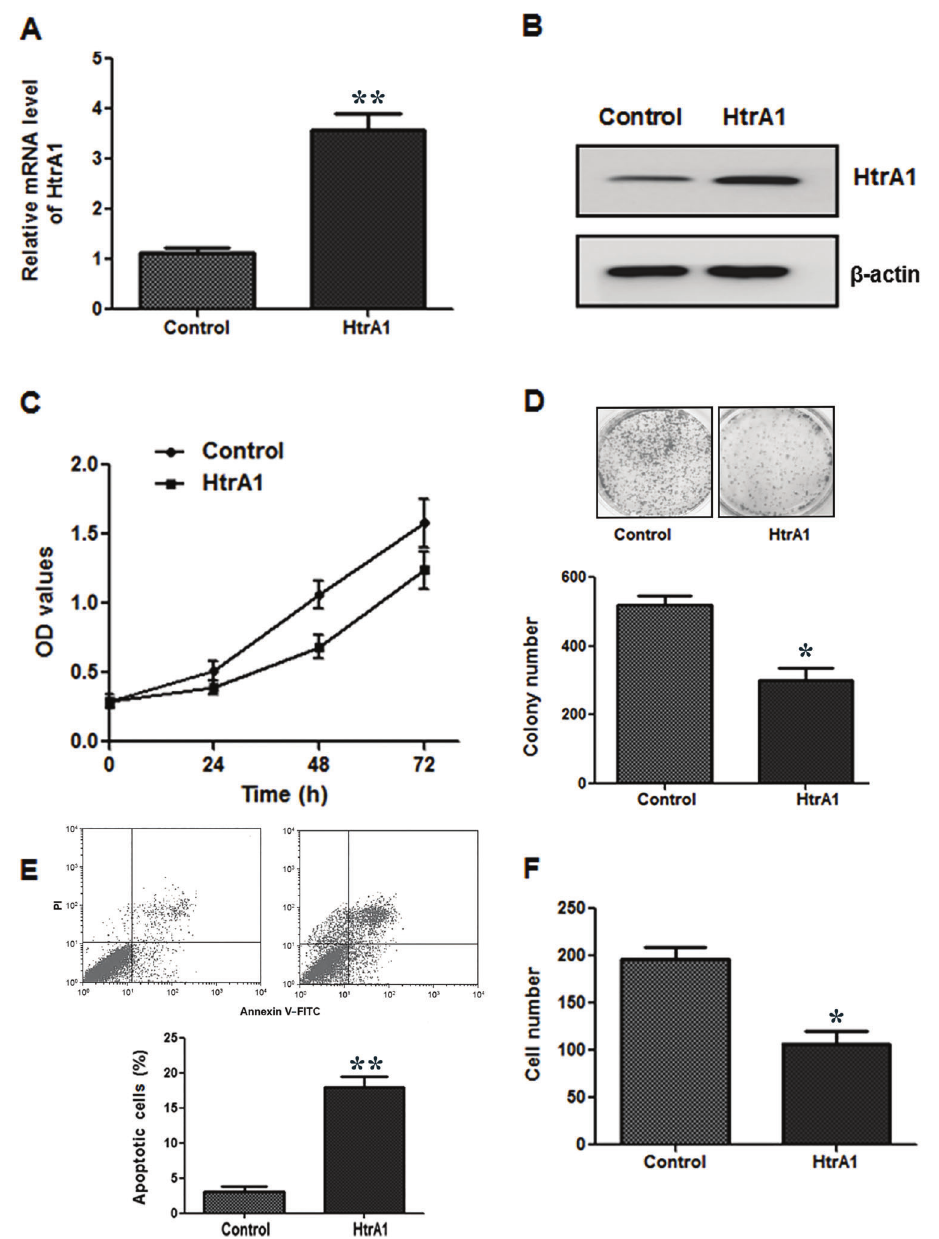
Figure 2. Role of up-regulated high temperature requirement factor A1 (HtrA1) on pancreatic cancer cell growth, apoptosis, and migration. After transfection with pcDNA3.1-HtrA1 plasmids, the expression of HtrA1 was measured by real-time PCR ( A ) and western blot ( B ). CCK-8 assay ( C ) and colony formation assay ( D ) were performed to detect the cell viability and colony formation of PANC-1 cells. Flow cytometry and Transwell assay were used to evaluate the apoptosis ( E ) and migration ( F ) of PANC-1 cells. Data are reported as means ± SD. *P o 0.05; **P o 0.01 ( t expression of Notch-1 in pcDNA3.1-HtrA1 plasmid- signi fi cantly increased the Notch-1 transcripts in pancreatic transfected pancreatic cancer cells (Figure 4B). On cancer cells (Figure 4C). In addition, the protein expression the contrary, transfection with HtrA1-speci fi c siRNA of Notch-1 was obviously increased in PANC-1 cells upon